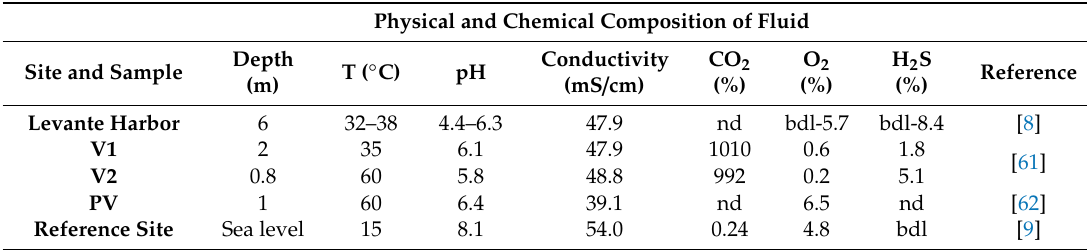
Figure 2. Levante Harbor at Vulcano Island and sampling site locations: V1, V2, and PV. Characteristics of sampling sites are reported in Table 2. Table 2. Main features of the fluids vented at Levante Harbor, Vulcano Island.